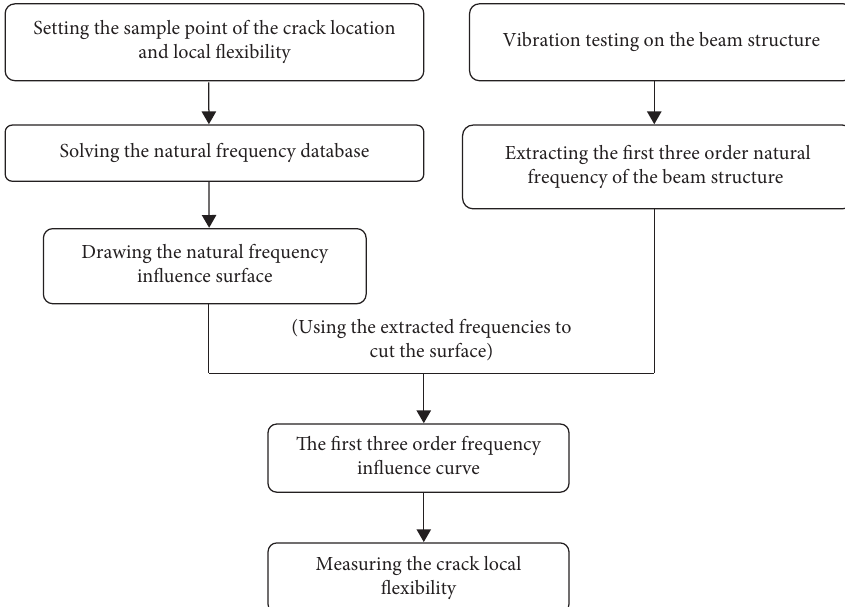
Figure 3: The flowchart of the method for measuring the crack local flexibility of the beam structure.